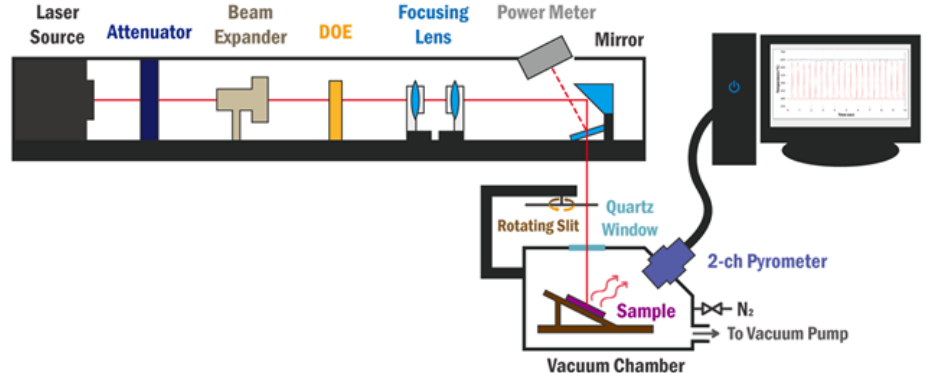
Figure 2. Schematic of the heat load test equipment. During the exposure, EUV light was incident on the pellicle with uniform intensity. An